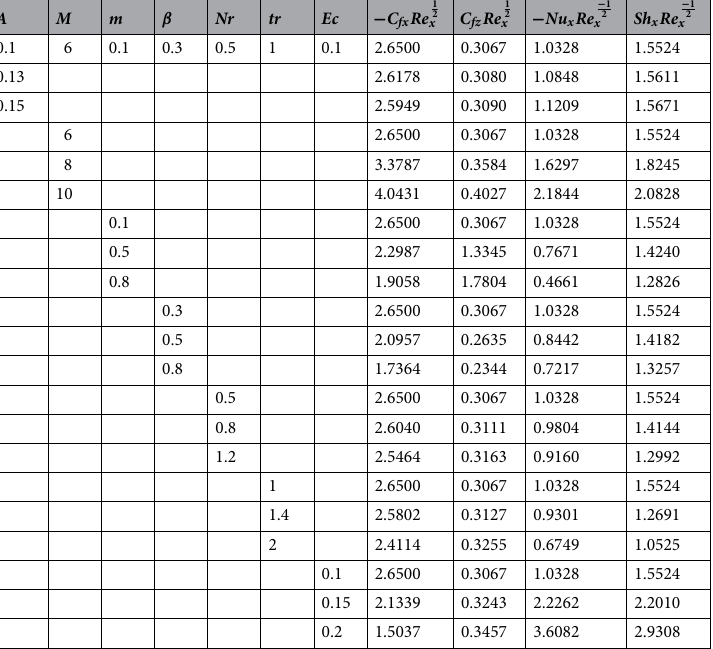
Table 1. Numerical values of skin friction coefficients